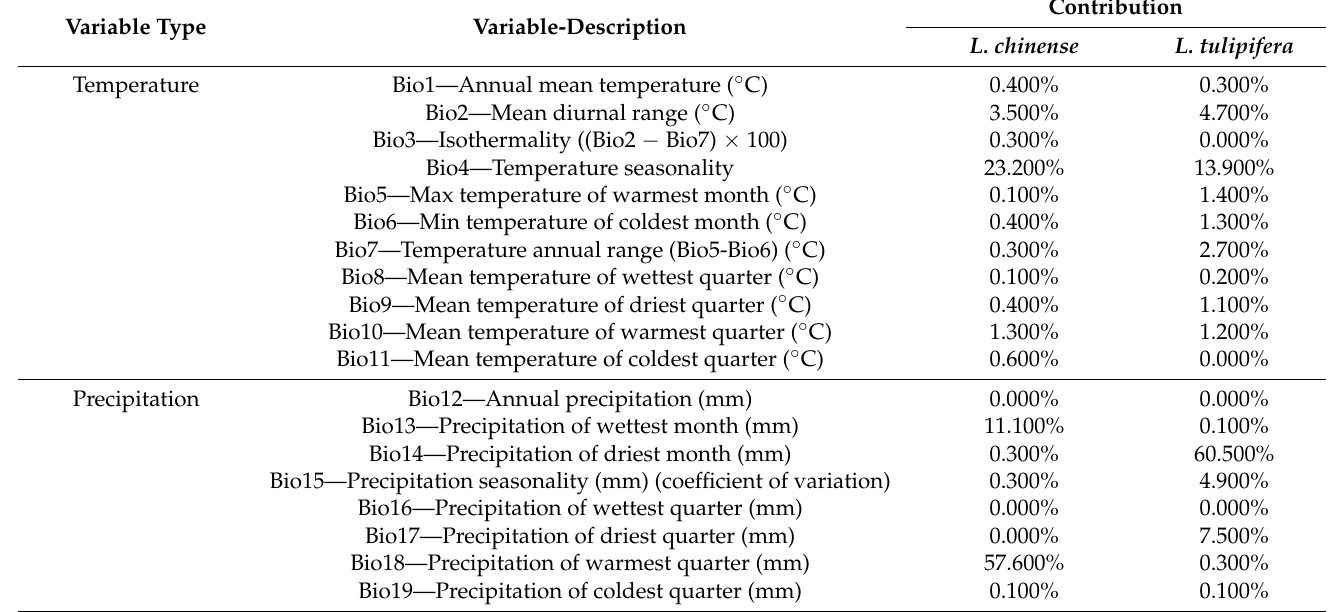
Table 1. Percentage contributions of the bioclimatic variables included in the Maxent models for Liriodendron